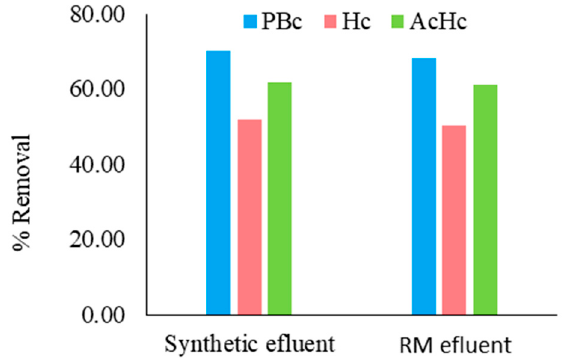
Figure 13. The removal efficiency of lead on synthetic effluent and Rosia Montana mine drainage water (RM), C 0 = 20 mg/L Pb(II), C s = 0.5 g/L char, T = 23 ± 1 °C, 4 h contact time.